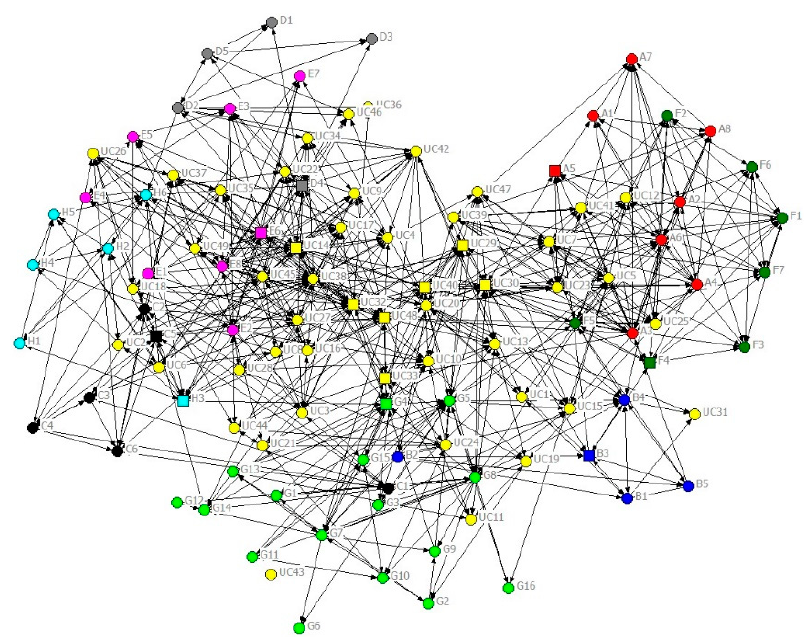
Figure 2. Phase 1 sociogram for general communication (strength of tie = 3 and organisation and key contact attribute display).